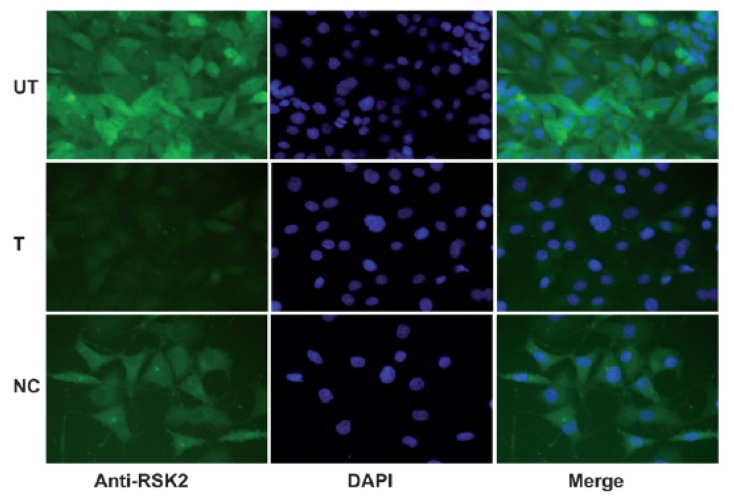
Immunocytofluorescence studies. RSK2 expression in untransfected (UT), transfected with the Rsk2-shRNA (T) or the scrambled-shRNA (negative control, NC) PC12 cells. The anti-RSK2 antibody reveals a strong RSK2 staining in UT and NC cells, whereas the signal is very faint in Rsk2-shRNA transfected (T) cells, confirming the dramatically decreased expression of RSK2 in Rsk2-shRNA transfected cells (UT: n > 3, T: n > 3, NC: n > 3). DAPI: 4′,6′-diamidino-2-phénylindole.